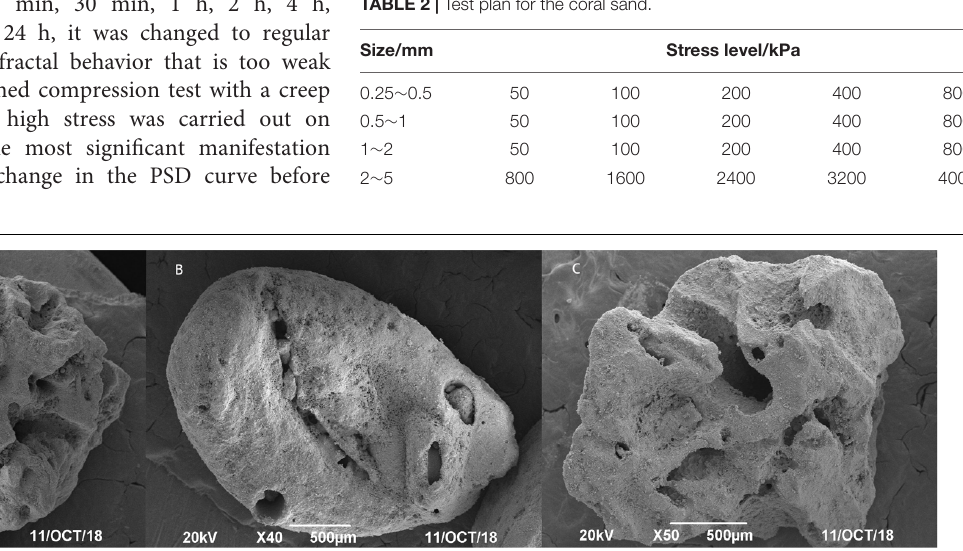
FIGURE 2 | (A–C) Selected more obvious SEM images of coral